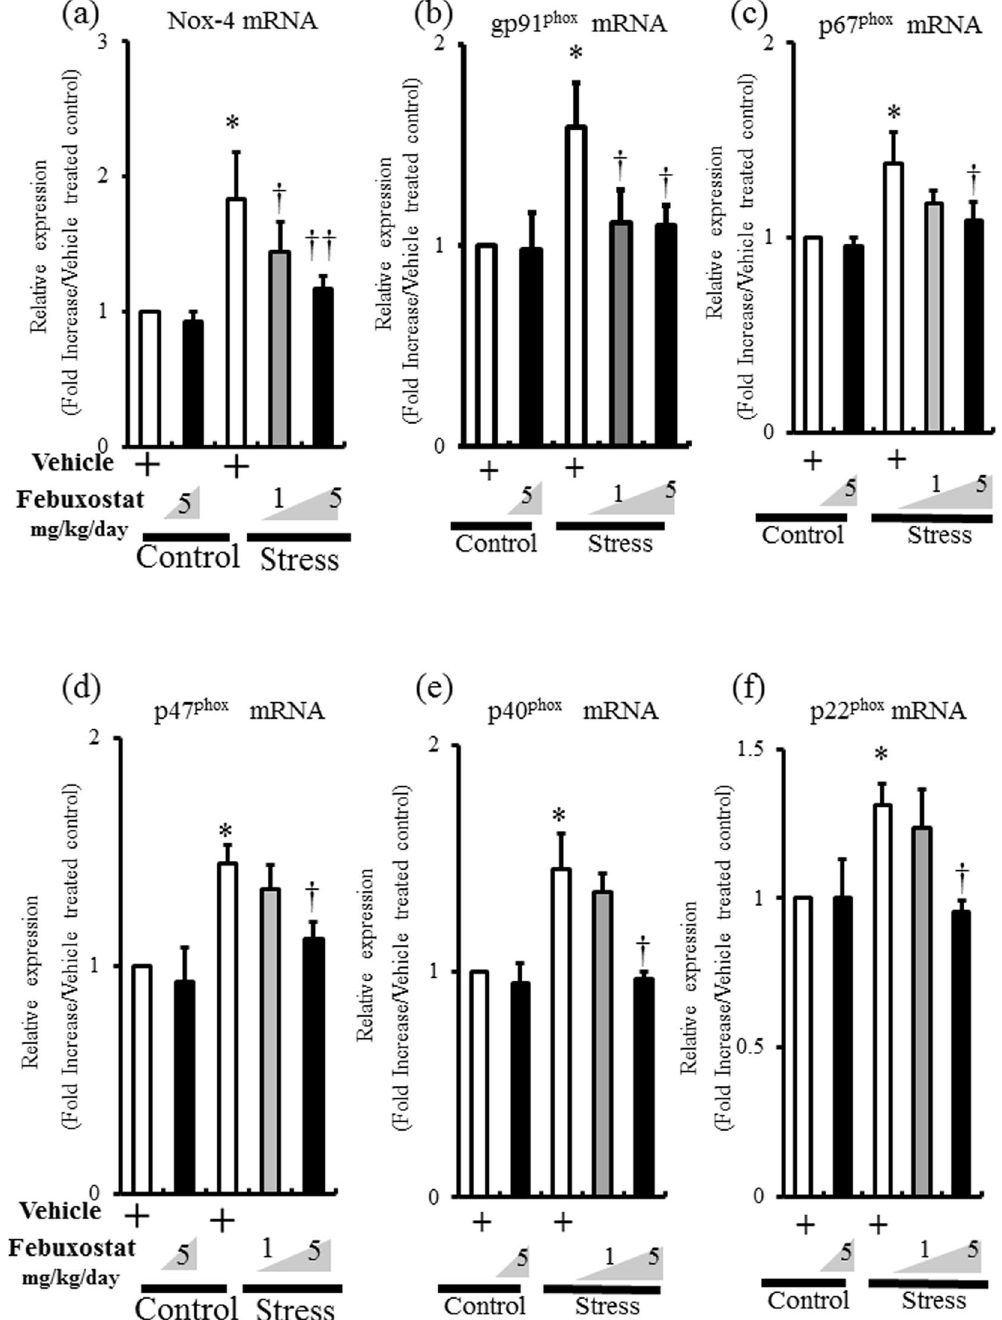
Figure 3. Febuxostat suppresses stress-induced increase in NOX subunits. The mRNA expression levels of NADPH oxidase subunits in inguinal adipose tissue of control mice treated with vehicle or febuxostat (5 mg/ kg/day), and stressed mice treated with vehicle or febuxostat (1 or 5 mg/kg/day) were analyzed by quantitative RT-PCR. Values are expressed relative to the vehicle-treated control mice. Data were analyzed by Student’s t-test and displayed as mean ± SD of 5–6 mice per group. ( a ) NOX-4 mRNA expression in adipose tissue. * P < 0.002, compared with the vehicle-treated control mice, † P < 0.03 and †† P < 0.008, compared with the vehicle-treated stressed mice. ( b ) gp91 phox mRNA expression in adipose tissue. * P < 0.02 vs compared with the vehicle-treated control mice, † P < 0.05, compared with the vehicle-treated stressed mice. ( c ) p67 phox mRNA expression in adipose tissue. * P < 0.02, compared with the vehicle-treated control mice, † P < 0.05, compared with the vehicle- treated stressed mice. ( d ) p47 phox mRNA expression in adipose tissue. * P < 0.002, compared with the vehicle- treated control mice, † P < 0.009, compared with the vehicle-treated stressed mice. ( e ) p40 phox mRNA expression in adipose tissue. * P < 0.004, compared with the vehicle-treated control mice, † P < 0.006, compared with the vehicle-treated stressed mice. ( f ) p22 phox mRNA expression in adipose tissue. * P < 0.017, compared with the vehicle-treated control mice, † P < 0.011, compared with the vehicle-treated stressed